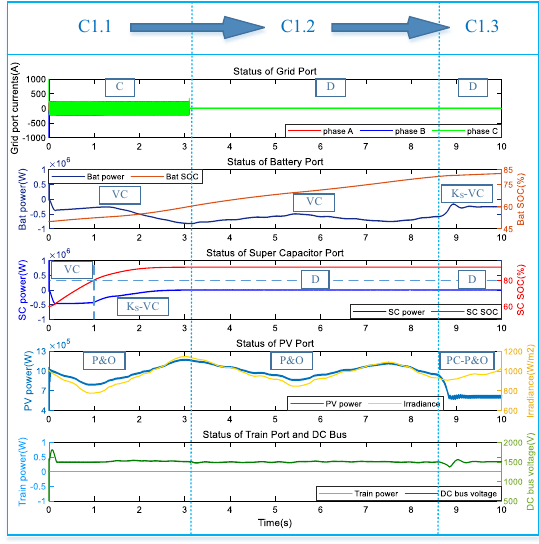
Fig. 12 Simulation waveform diagram of each port for switching between typical working conditions when the train is stopped